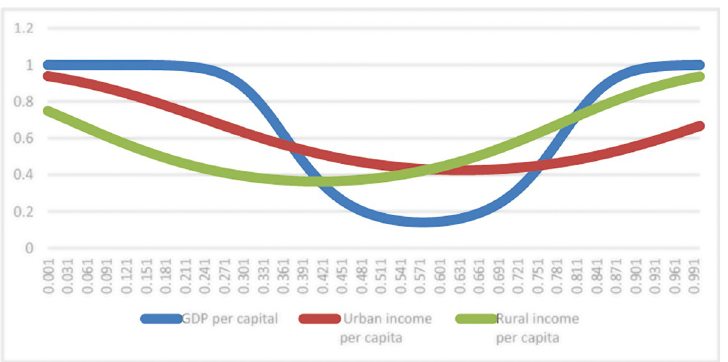
Fig 1. Transition functions under different explanatory variables in model